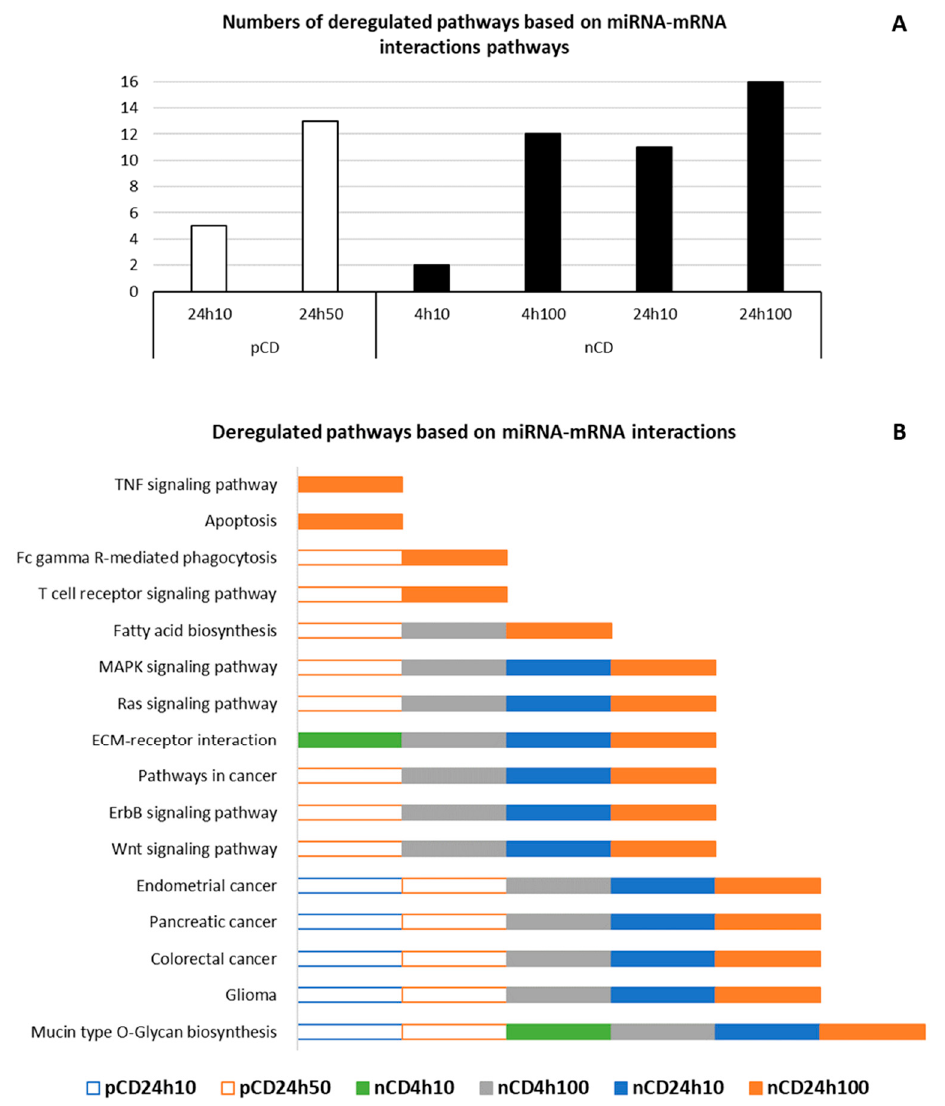
Figure 12. Graphically illustrated overview of deregulated pathways based on miRNA-mRNA interactions after CD NPs exposure. Number ( A ) and identity ( B ) of deregulated pathways per CD, dose and exposure time (empty rectangles denote pCD exposure, filled rectangles denote nCD exposure).